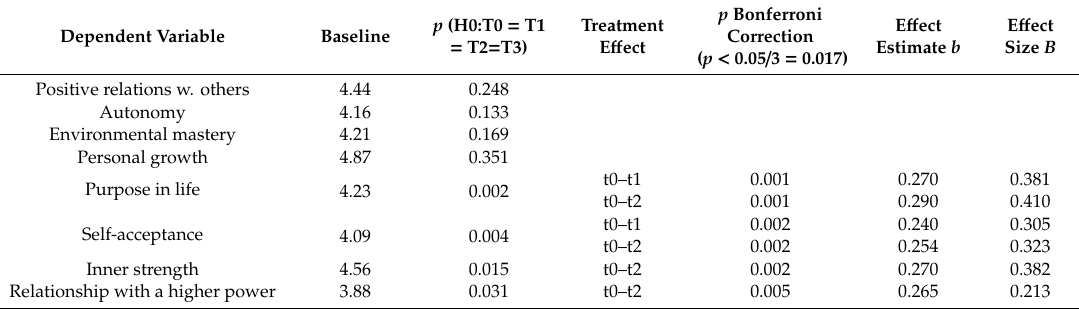
Table 7. Psycho-Spiritual Wellbeing (Dutch RYFF). 1,